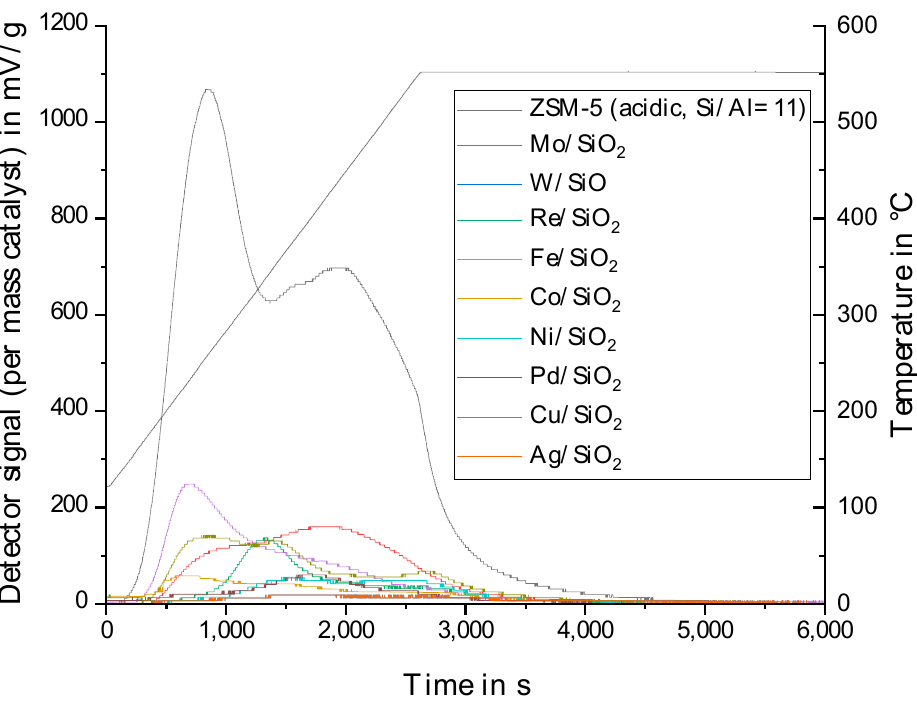
Figure 10. Comparison of TPAD of the investigated catalyst systems with a commercially available HZSM-5 (Clariant). ZSM-5 = 1260 µmol/g, Mo/SiO 2 = 210 µmol/g, W/SiO 2 = 135 µmol/g, Re/SiO 2 = 80 µmol/g, Fe/SiO 2 = 220 µmol/g, Co/SiO 2 = 185 µmol/g, Ni/SiO 2 = 105 µmol/g, Pd/SiO 2 = 75 µmol/g, Cu/SiO 2 = 180 µmol/g, Ag/SiO 2 = 35 µmol/g.